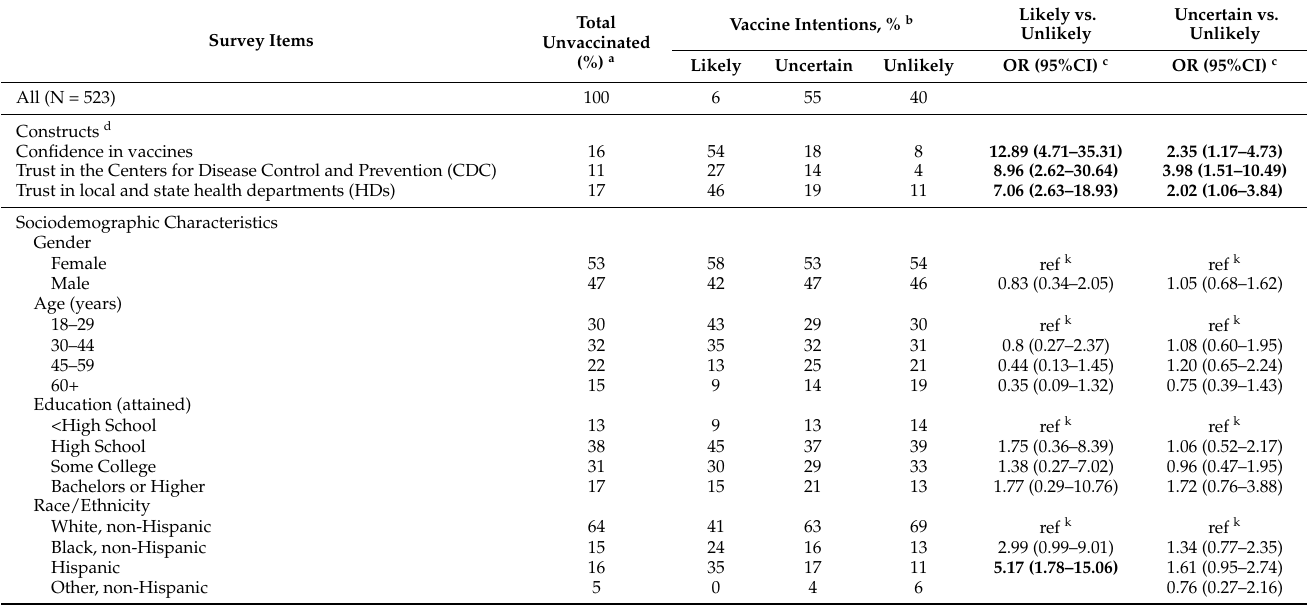
Table 3. Frequency and Odds of Intention to Get COVID-19 Vaccine (3 groups) among Unvaccinated by Vaccine Attitudes, Trust in CDC and HDs, and Sociodemographic Characteristics. Numbers in the “Total” column indicate the percentage of the unvaccinated weighted sample providing the September 2021 survey response in each row. Numbers in the “Vaccine Intentions” columns indicate the percentage of those whose COVID-19 vaccine intentions match that of the column header who provided the survey response in each row. The numbers in the “OR (95%CI)” columns indicate the Odds Ratio comparing the different vaccine intentions matching that of the column header by the survey response in each row, boldface indicating statistical significance ( p <